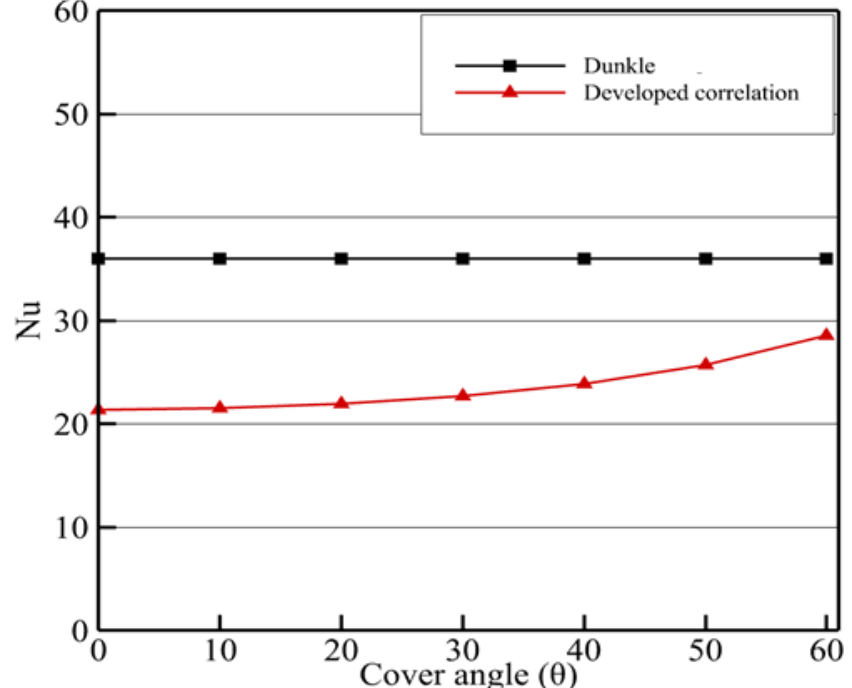
Figure 17. Nusselt number variation for different cover angles at AR = 2.78.